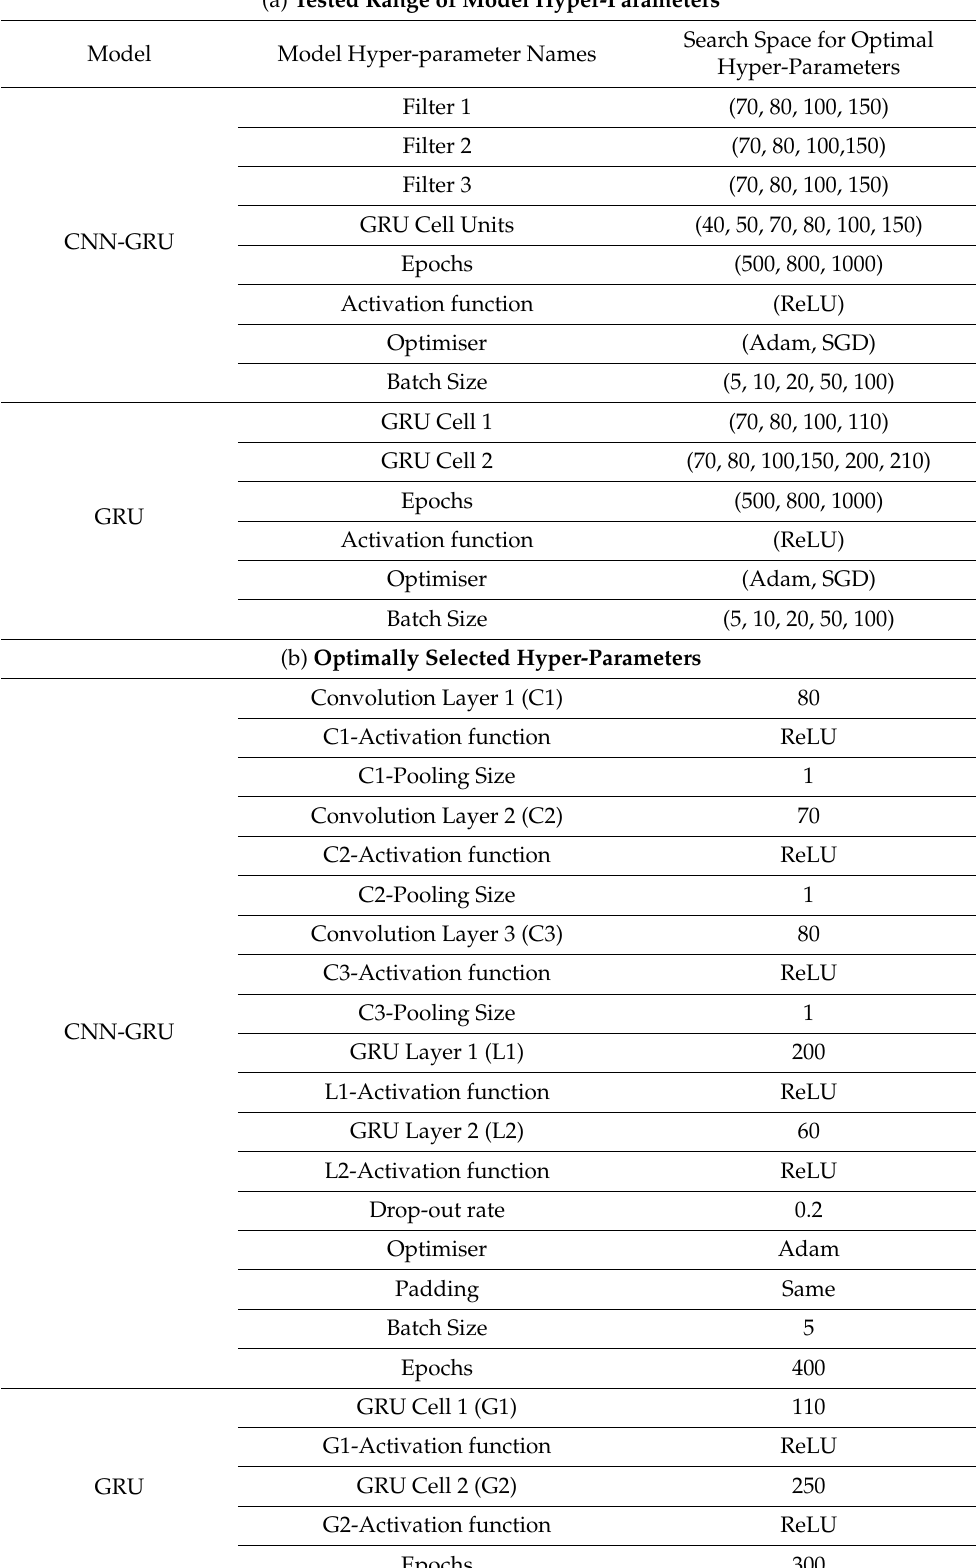
Table 3. (a) Range of tested hyperparameters in designing hybrid CNN-GRU and GRU predictive models through trial and error method. (b) Optimally selected hyperparameters. ReLU stands for Rectified Linear Units, SGD stands for stochastic gradient descent